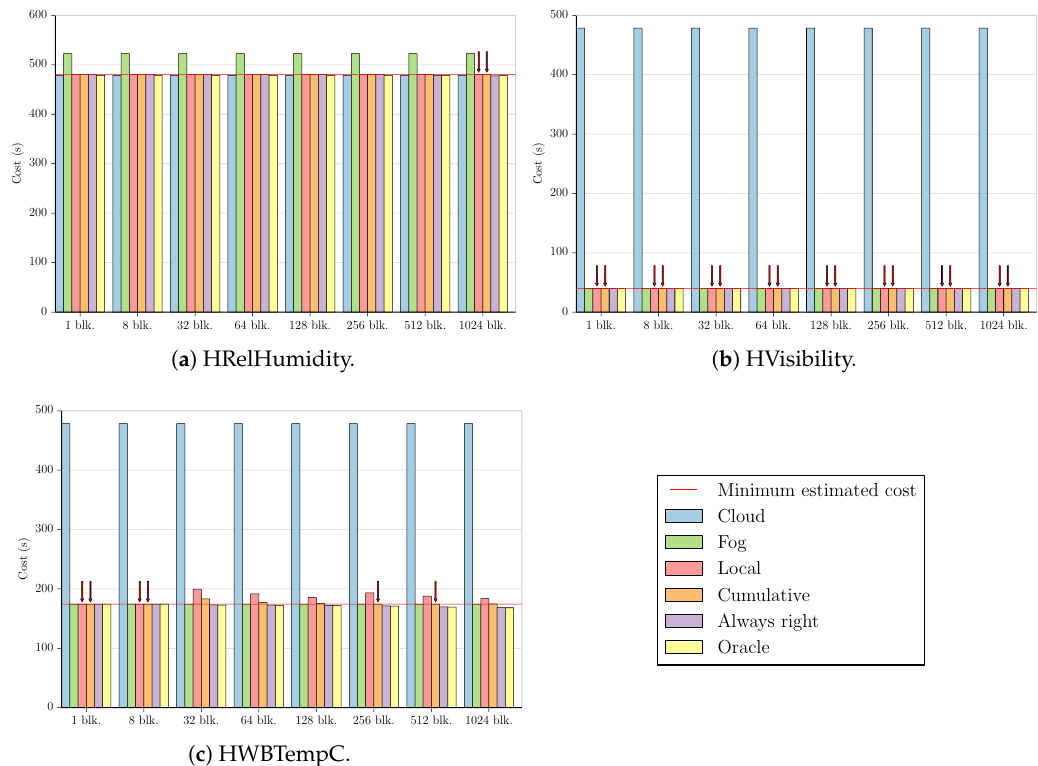
Figure 2. Summary of the results for MinMax [ − 15,15 ] fog-prone test cases. Blk.,